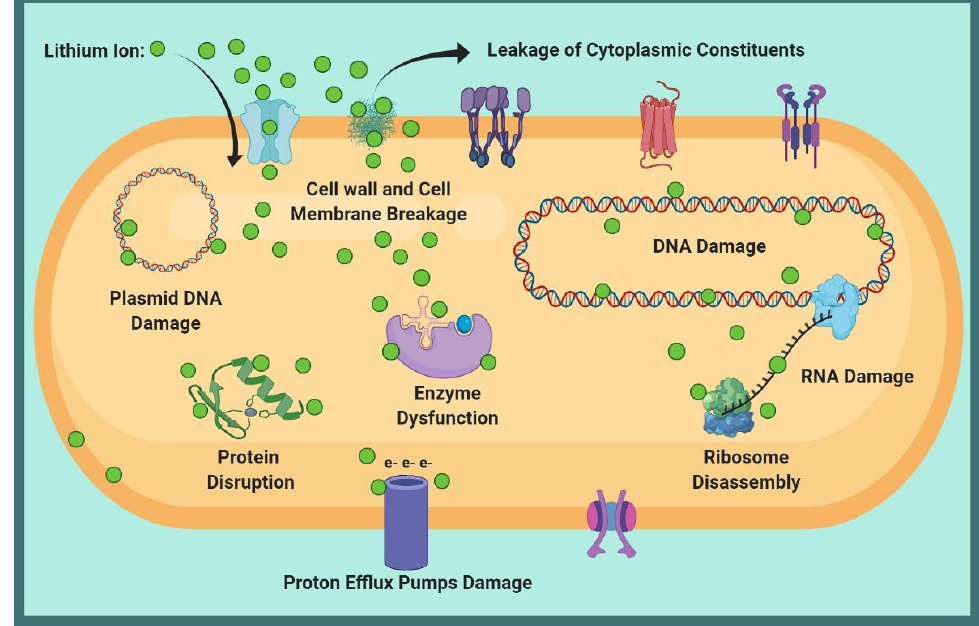
Figure 12. Schematic of the possible Li function against bacteria.